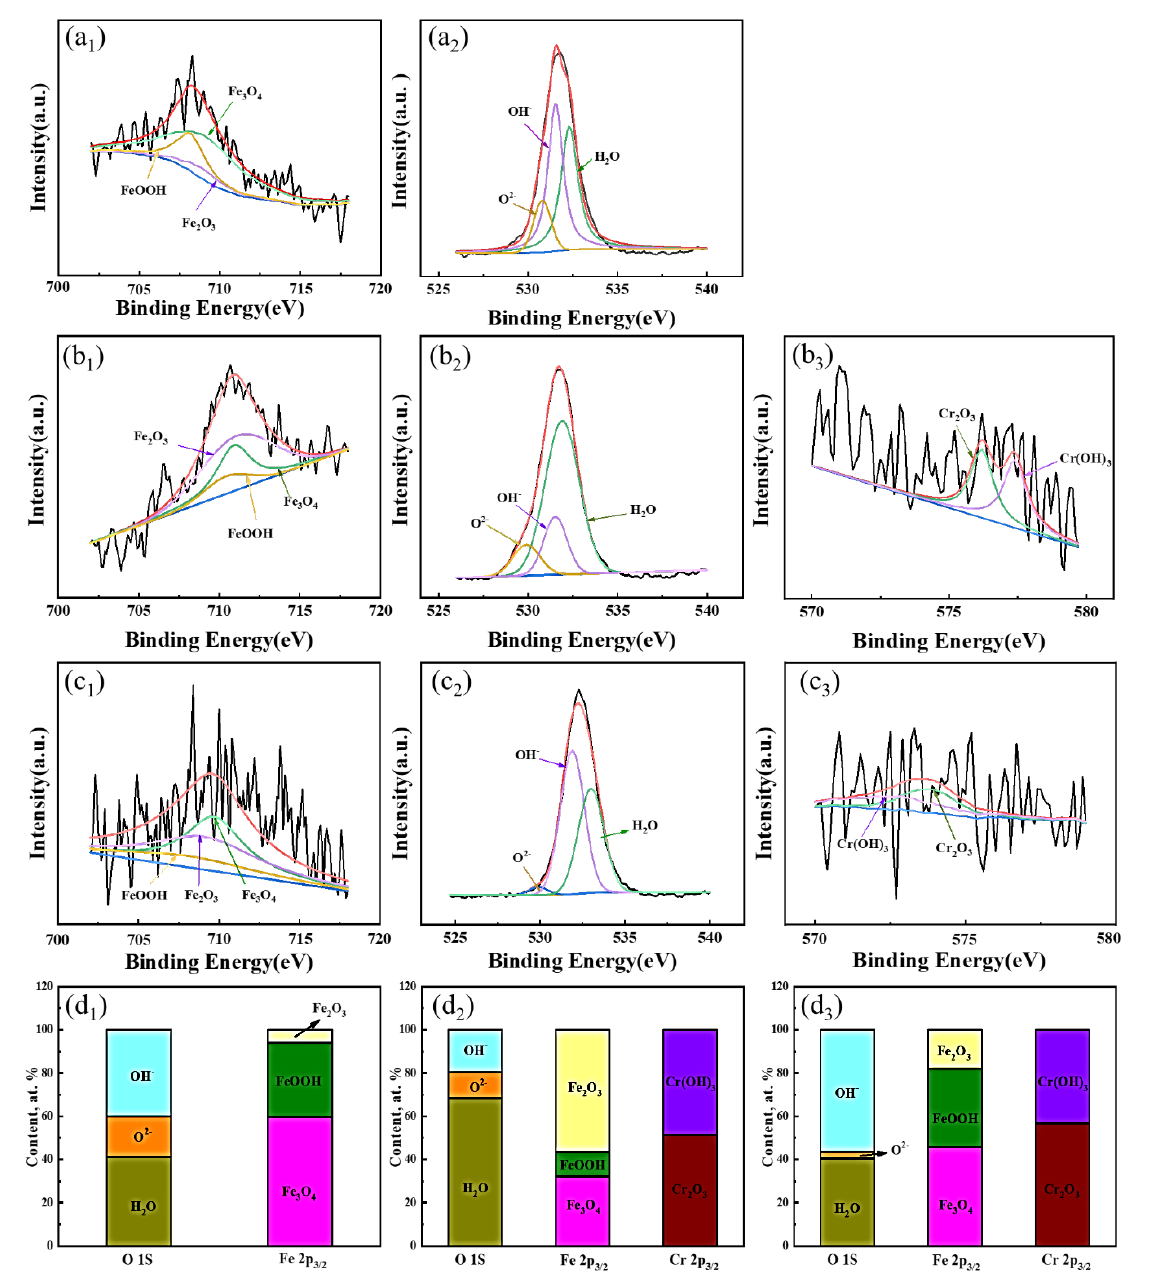
Figure 7. XPS results of Fe 2p3/2, Cr 2p3/2, and O 1 s , marked by 1, 2, and 3, of the passive film on ( a ) BM, ( b ) Cr, and ( c ) RE steel rebars formed in the saturated Ca(OH) 2 solution for 24 h. ( d ) Content percentage of each substance.